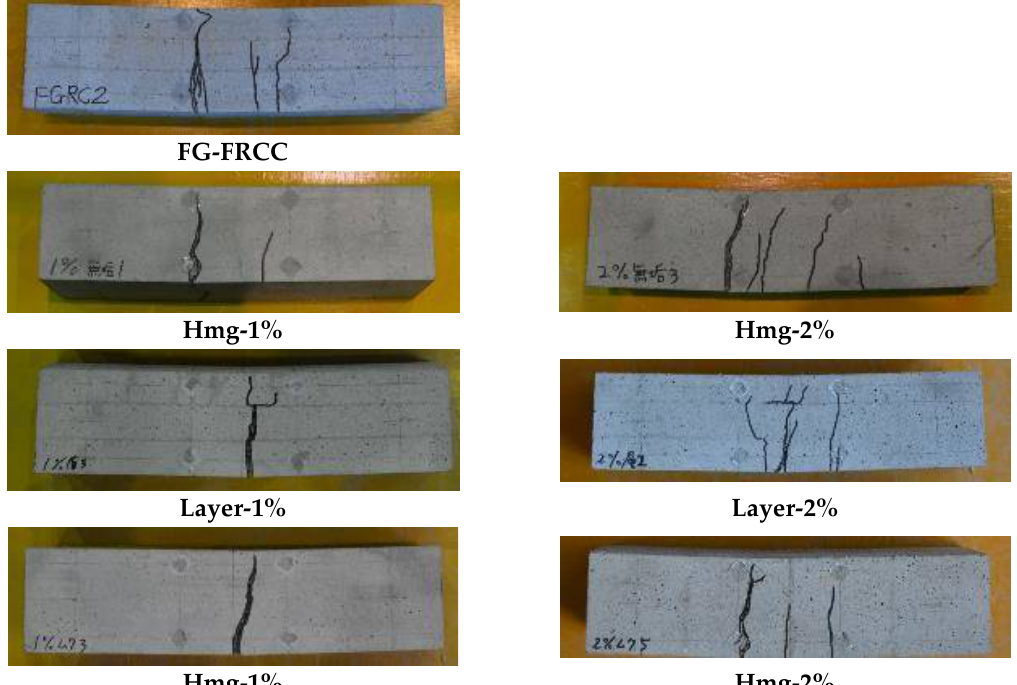
Figure 4. Typical examples of the specimens after loading.